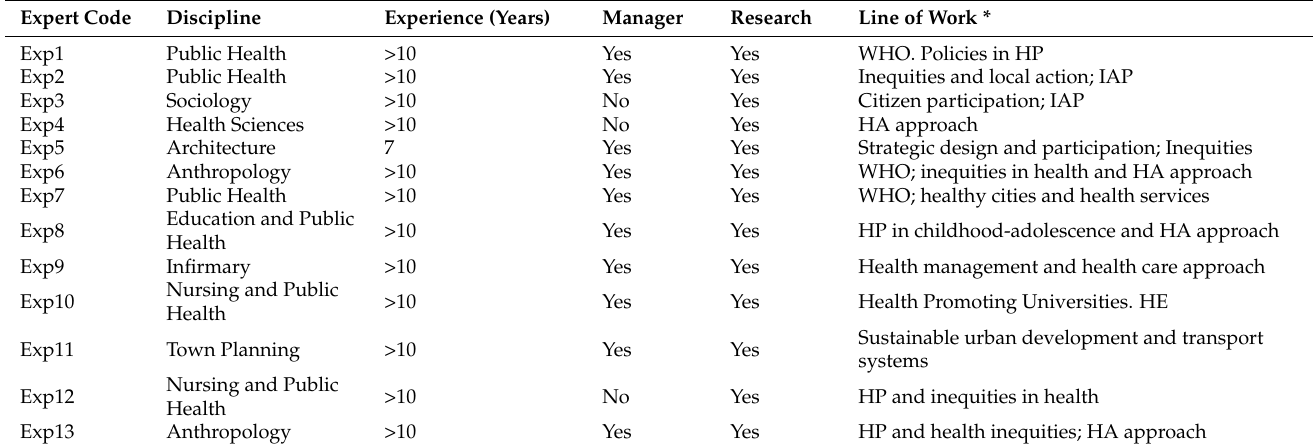
Table 1. Profiles of the Delphi panel